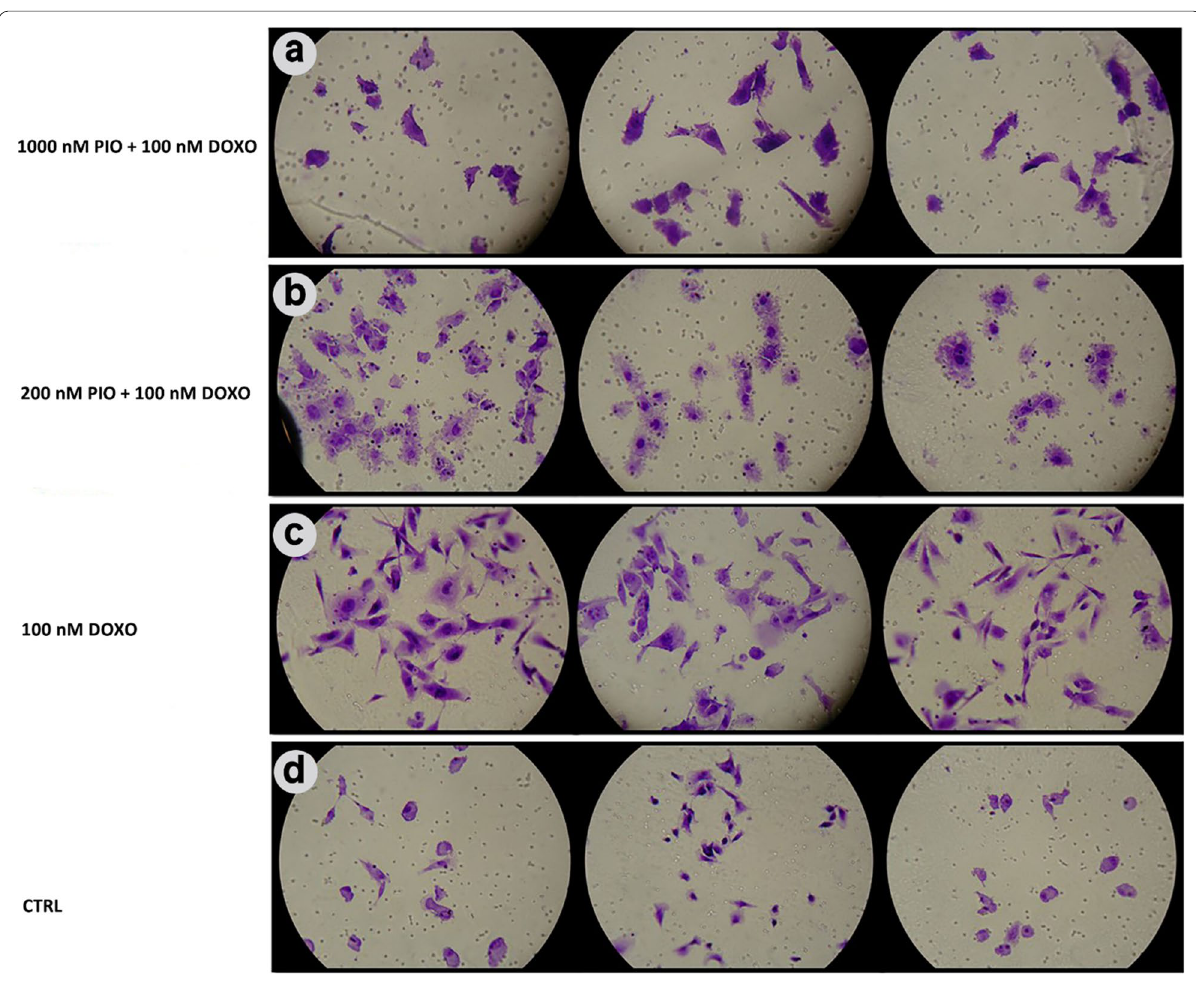
Fig. 5 Results of Transwell migration assay under FBS concentration gradient after 18 h shows the number of migrated cells treated with a 1000 nM PIO and DOXO, b 200 nM PIO and DOXO, c 100 nM DOXO alone, and d the control